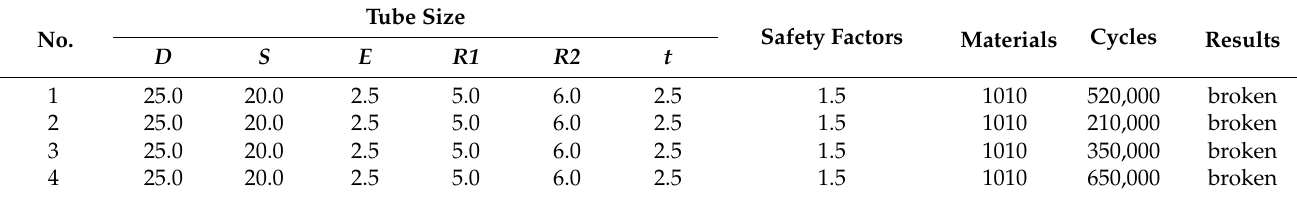
Table 3. Fatigue experimental results of the conically corrugated tubes.